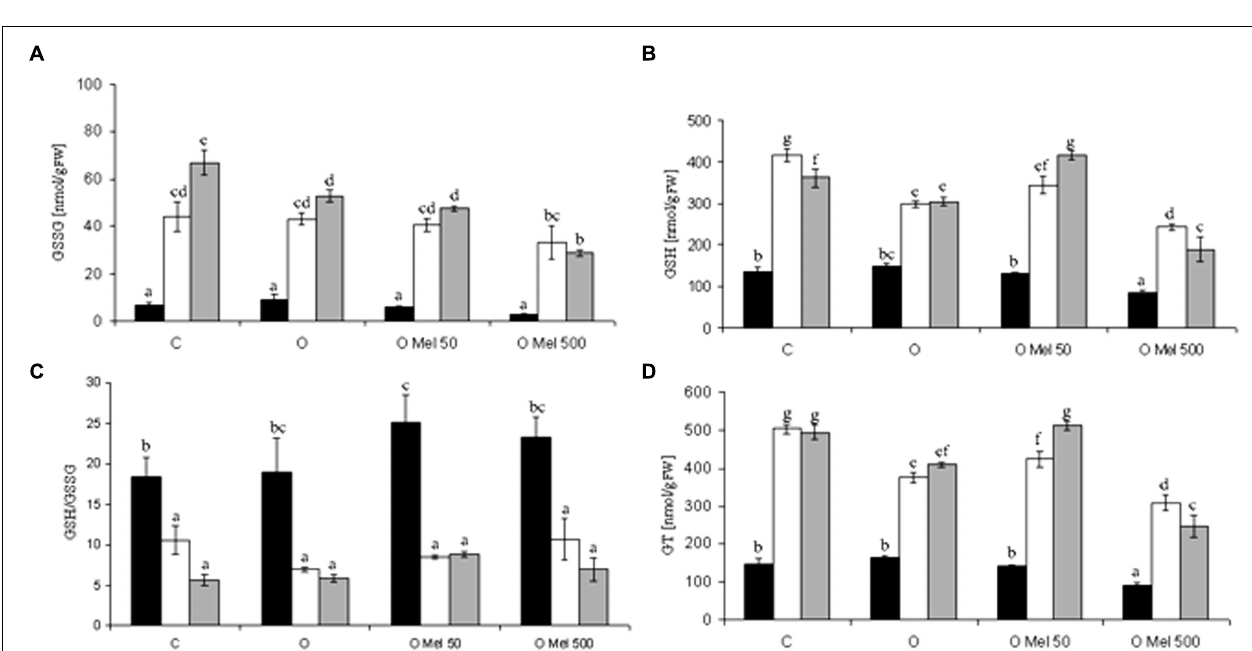
FIGURE 2 | Effect of cucumber seed osmopriming variants on glutathione pool: GSSG – oxidized glutathione (A), GSH – reduced glutathione (B), GSH/GSSG ratio (C), GT – total glutathione (D) in the axes isolated from seeds: control - untreated (C), osmoprimed without (O) and with melatonin at concentrations: 50 µ M (OMel50) and 500 µ M (OMel500). The seeds were imbibed/germinated in water at 10 ◦ C in darkness for 7 days (CS7– (cid:3) ), and then subsequently recovered at 25 ◦ C for 2 days (R2 – (cid:4) ). Glutathione pool was also estimated in the axes isolated from the seeds germinated for 24 h in optimal conditions 25C (to – (cid:4) ). The results are expressed as mean values of nine measurements ± SEM. Two-way ANOVA and Duncan’s post hoc test were performed. The small letters next to the values show statistical significance p < 0.001. GSSG ANOVA results (A) : Variant (C, O, OMel50, OMel500) F(3.56) = 12.8, p < 0.001, Crucial Point (to, CS7, R2) F (2.56) = 152.4, p < 0.001 and interaction Variant × Crucial Point F (6.56) = 4.3, p < 0.001. GSH ANOVA results (B) : Variant (C, O, OMel50, OMel500) F (3.57) = 45.56, p < 0.001, Crucial Point (to, CS7, R2) F (2.57) = 214.55, p < 0.001 and interaction Variant × Crucial Point F (6.57) = 9.5, p < 0.001. GSH/GSSG ANOVA results (C) : Variant (C, O, OMel50, OMel500) F (3.54) = 1.77, p < 0.05, Crucial Point (to, CS7, R2) F (2.54) = 53.55, p < 0.001 and interaction Variant × Crucial Point F (6.54) = 0.823, p < 0.05. GT ANOVA results (D) : Variant (C, O, OMel50, OMel500) F (3.59) = 65.3, p < 0.001, Crucial Point (to, CS7, R2) F(2.59) = 403.6, p < 0.001 and interaction Variant ∗ Crucial Point F (6.59) = 12.3, p < 0.001.